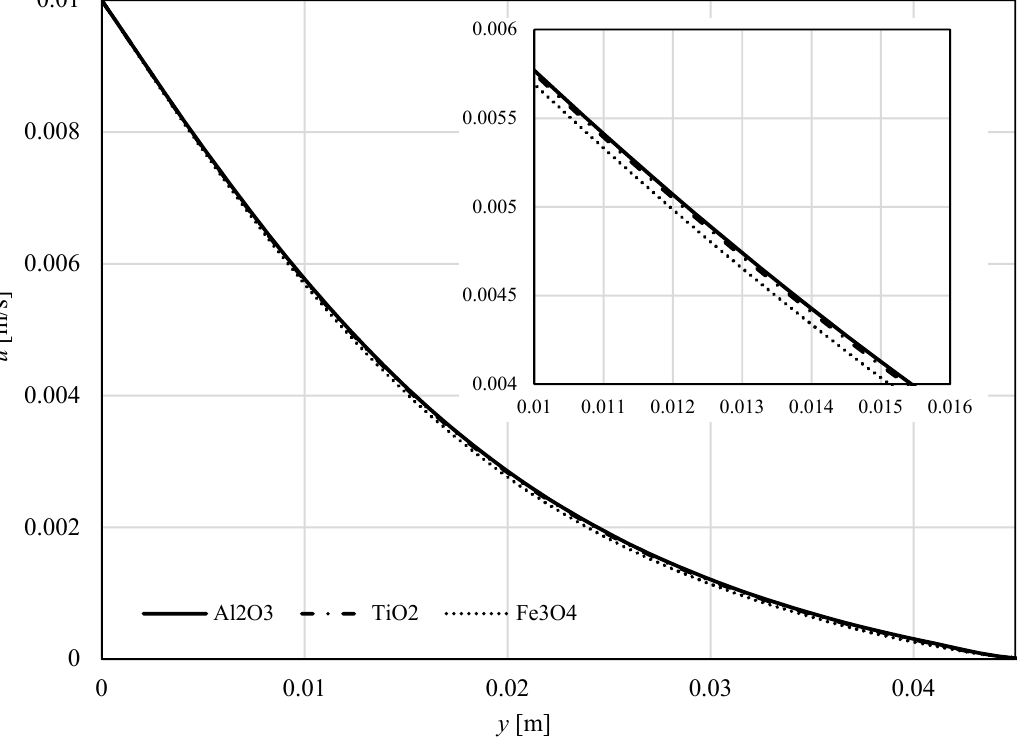
Figure 6. Velocity profiles perpendicular to the sheet for all three nanofluids; 𝜙 = 0.02 .